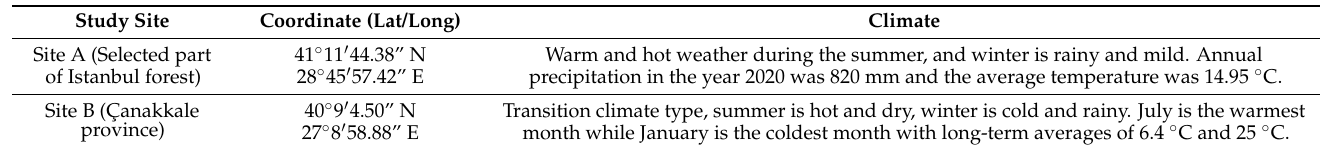
Figure 1. Location of two study areas. ( A ) Euxine–Colchic deciduous forests over Istanbul; ( B ) Anatolian coniferous and deciduous forests over Çanakkale province. Table 1. Geographical and climatic features of each study area.